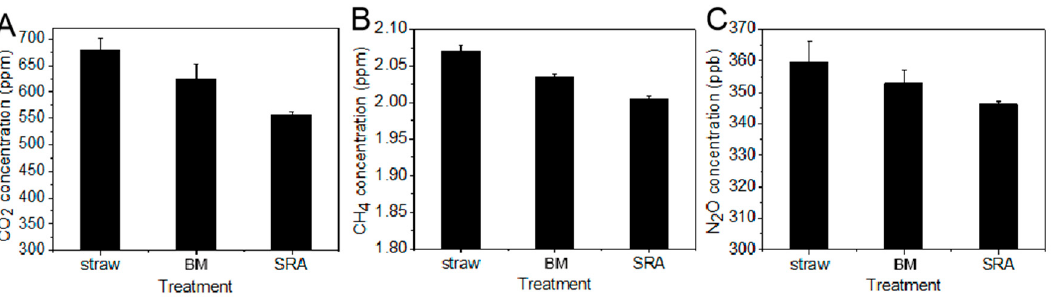
Figure 5. ( A – C ) CO 2 , CH 4 , and N 2 O concentrations from maize fields after returning of wheat straw alone and those treated by BM and SRA for 60 days, respectively.